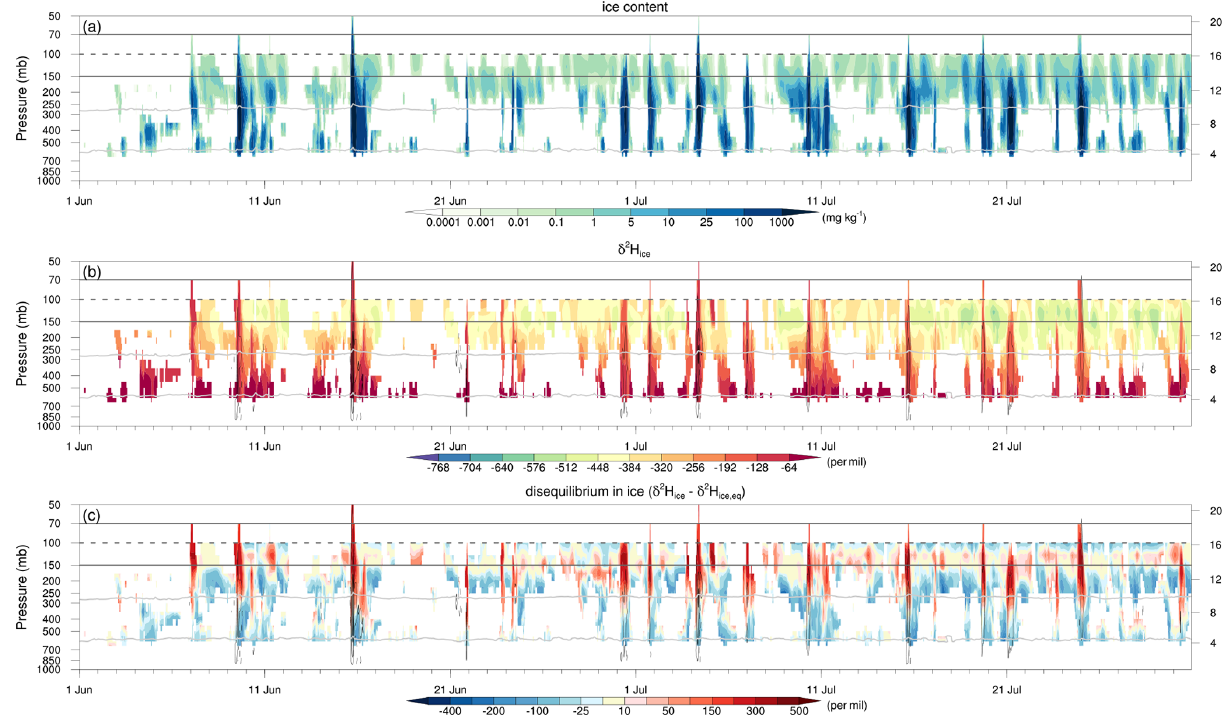
Figure 7. The temporal evolution of ice and its isotopic composition for the period from 1 June to 30 July 2016 for the (a) ice content (mgkg − 1 ), (b) δ 2 H in ice (‰), and (c) disequilibrium in ice (‰) averaged over a small region (14.5–15.5 ◦ N, 5–6 ◦ E), indicated by the black boxes in Fig. 6a–d. Variables in all panels are transparent when the domain average ice content values are below 10 − 4 mgkg − 1 . As in Fig. 6, the light grey contours denote the liquid, mixed-phase, and ice cloud layers; the dark grey solid contours denote the TTL region; and the dark grey dashed contours denote the approximate tropopause cold point. Black solid (dashed) contours again show the upward (downward) vertical motion but at intervals of 0.1, 0.5, 1, 2, and 5ms − 1